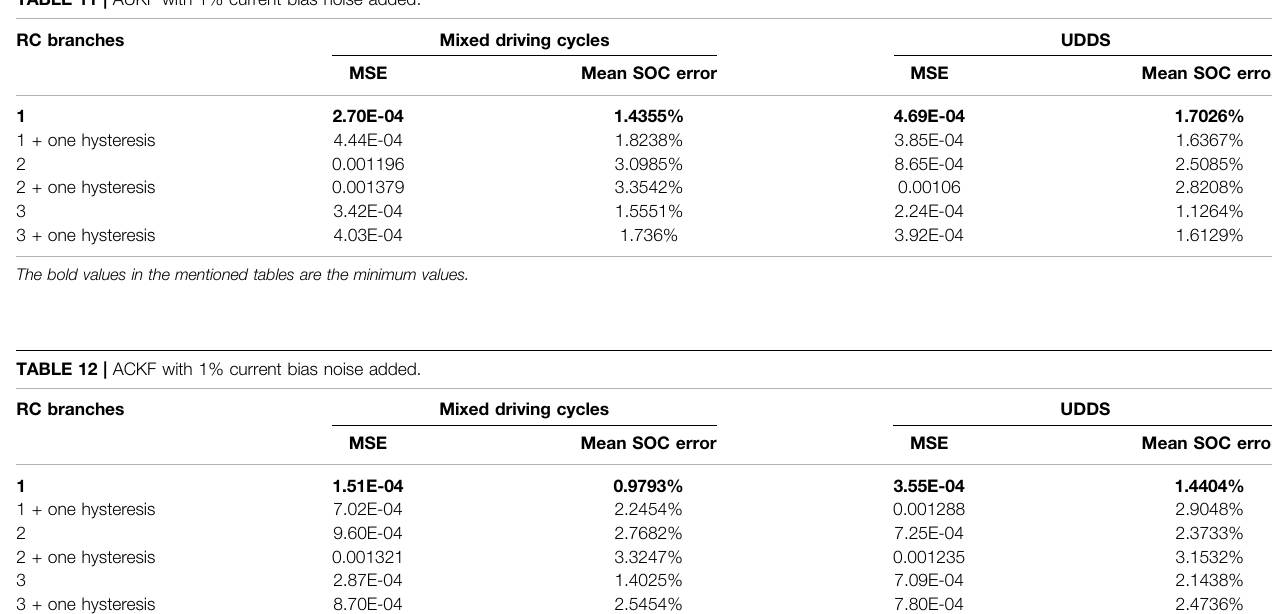
TABLE 11 | AUKF with 1% current bias noise added.